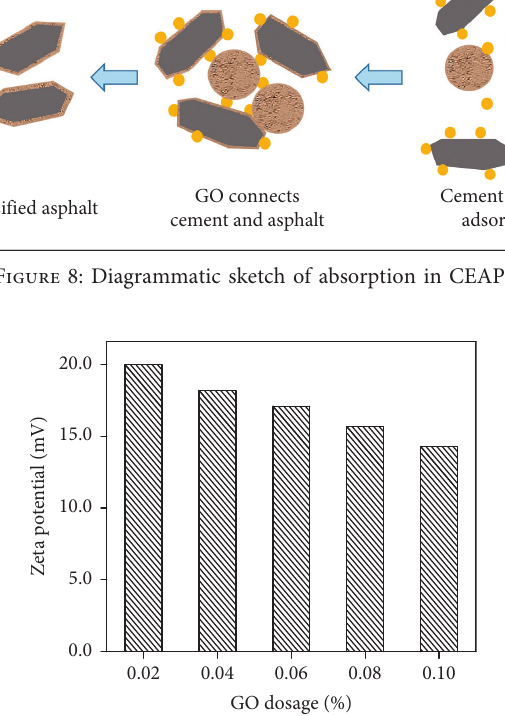
Figure 9: Zeta potential of CEAP with different GO dosages.